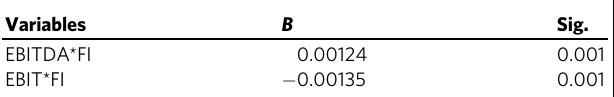
Table 9 GLS of EBITDA vs. EBIT and the impact of foreign